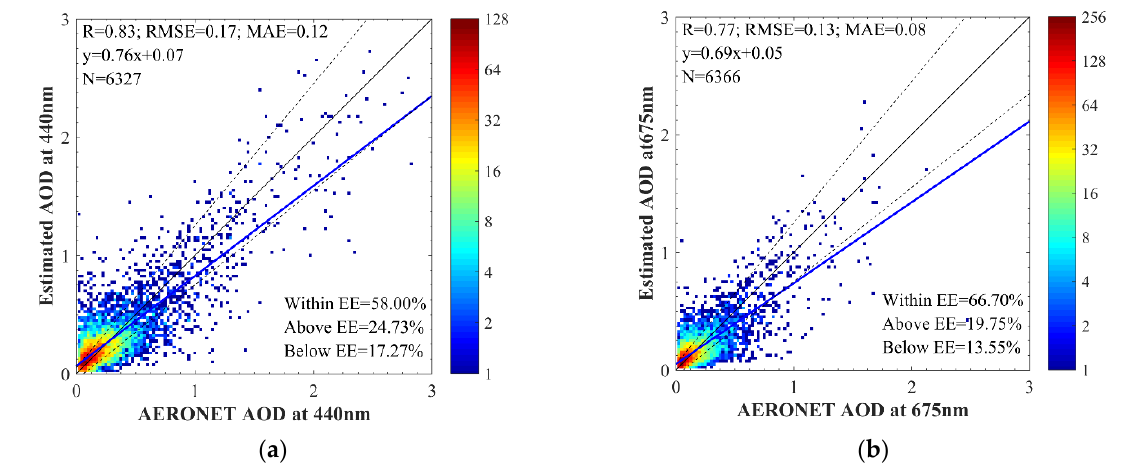
Figure 8. The scatterplots of the DNN estimated ( a ) 440 nm and ( b ) 675 nm AOD results against the corresponding AERONET AODs using the leave-one-station-out cross-validation.